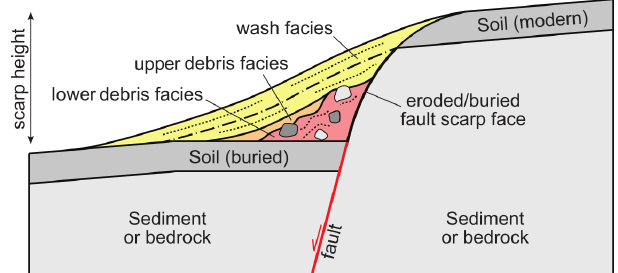
Figure 2. Schematic of the colluvial wedge conceptual model de- scribing morphology and stratigraphy. The lower debris facies rep- resent sediment deposited by initial collapse of the fault scarp, whereas the upper debris facies, wash facies, and overlying col- luvium represent deposition over longer timescales. Terminology adapted from Nelson (1992) and McCalpin